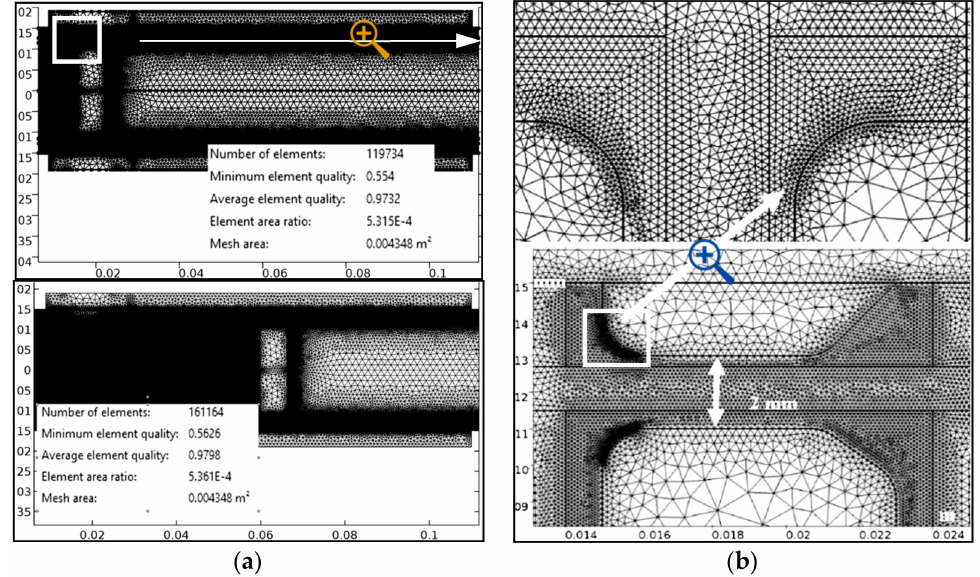
Figure 4. ( a ) Moving mesh with 119,734 elements in 43.48 cm 2 at first and 161,164 elements at the end and ( b ) Extremely fine mesh defined around contacts and